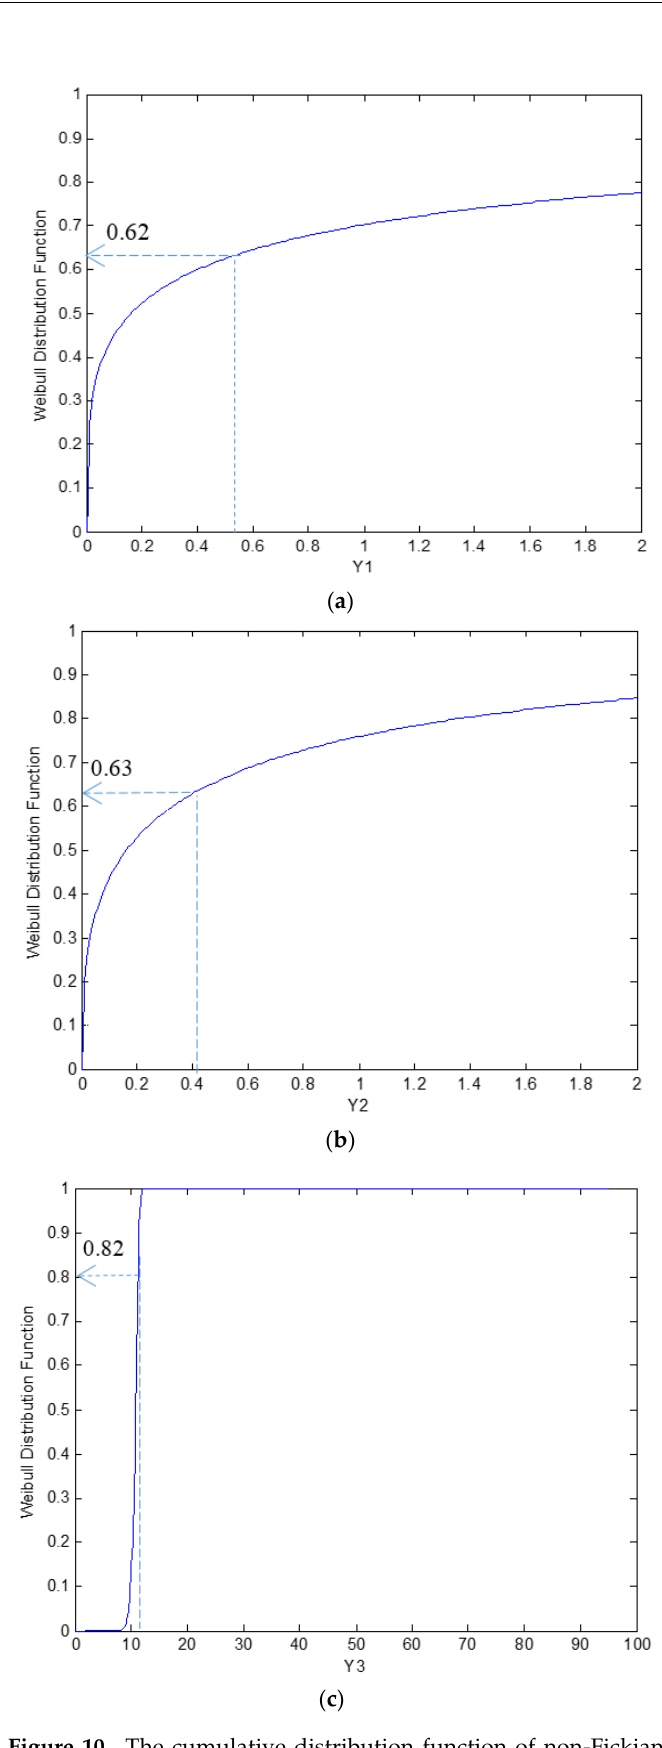
Figure 10. The cumulative distribution function of non-Fickian parameters for the normalized thickness: ( a ) Fickian to non-Fickian maximum moisture content ratio ϕ ; ( b ) normalized non-Fickian diffusivity per square thickness α ’; and ( c ) normalized non-Fickian initiation time t o ’.